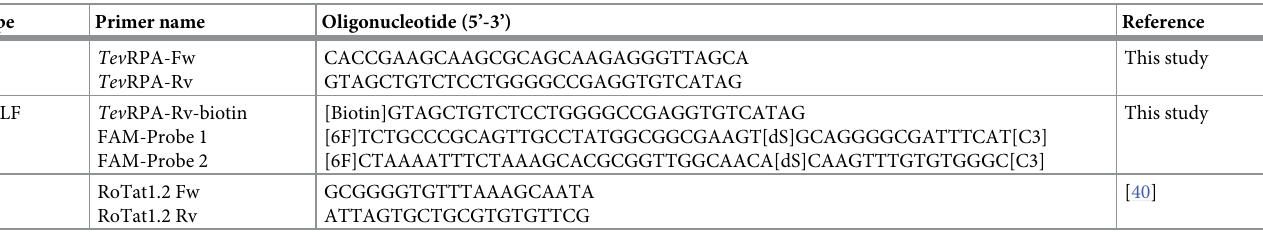
Table 2. Primers and probes employed in this